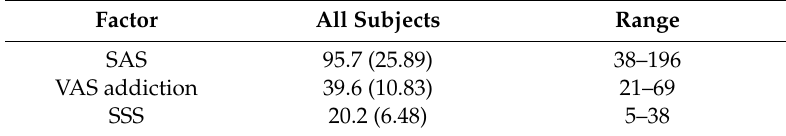
Table 3. Study 2—Questionnaire ratings in all participants n = 60 mean